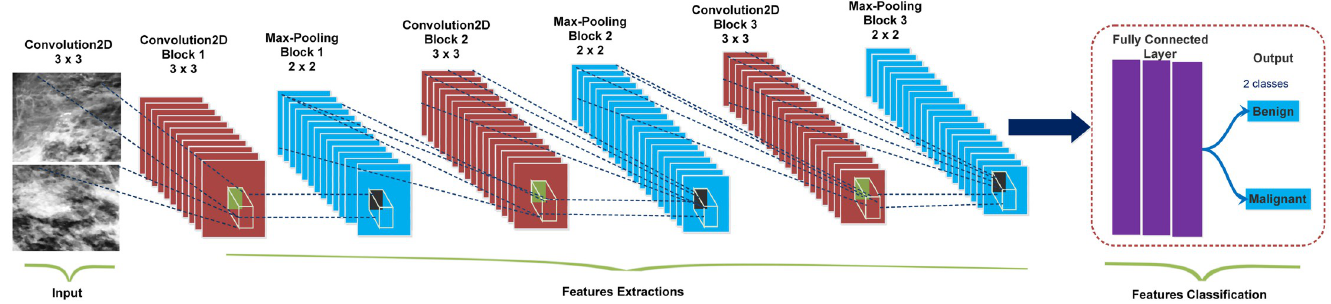
PLOS ONE | https://doi.org/10.1371/journal.pone.0263126 January 27,